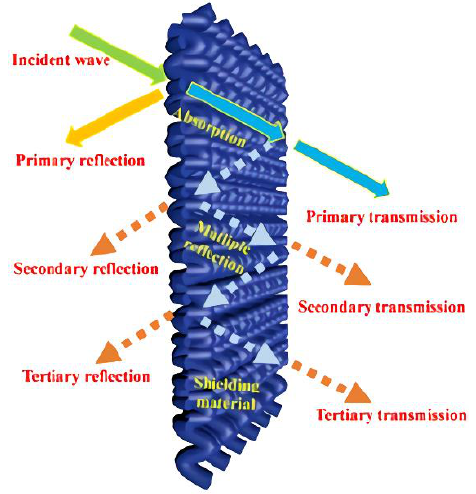
Figure 25. Possible interaction between electromagnetic/radiation and shielding materials [168].